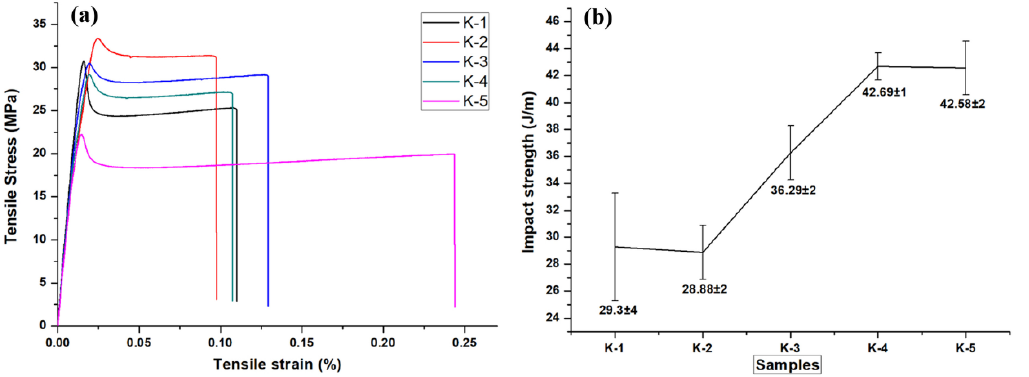
Figure 39. Mechanical properties ( a ): Tensile properties and ( b ): Impact strengths of recycled PS/HIPS/ABS ternary blends. Reprinted with permission from ref. [100].